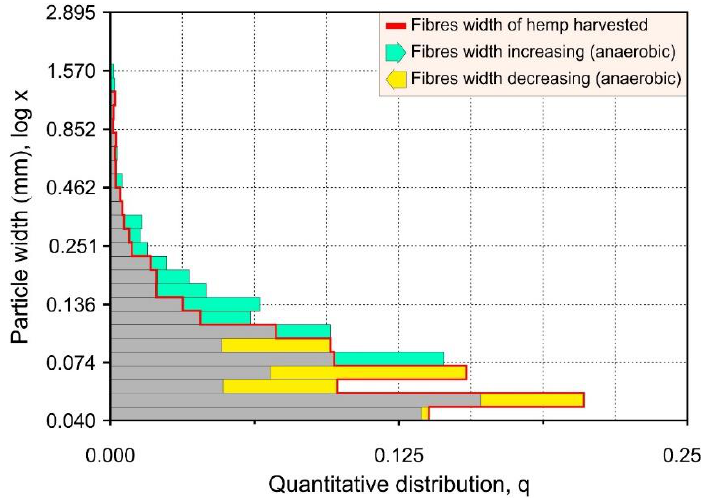
Figure 1. Width and quantitative distribution of the hemp fibres, using FiberShape.